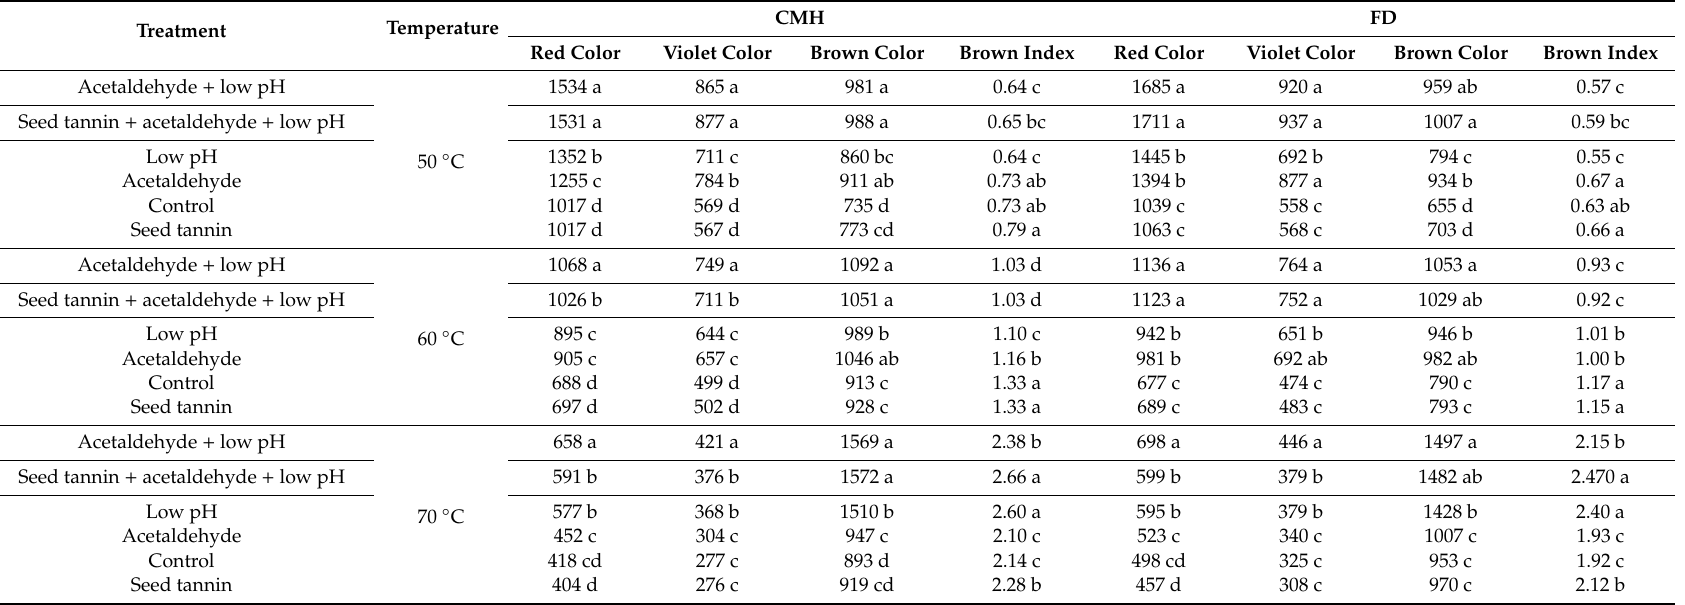
Values are means from two replicates. Means followed by di ff erent letters (within columns, at each temperature) are significantly di ff erent; α = 0.05; n = 2; Tukey’s pairwise